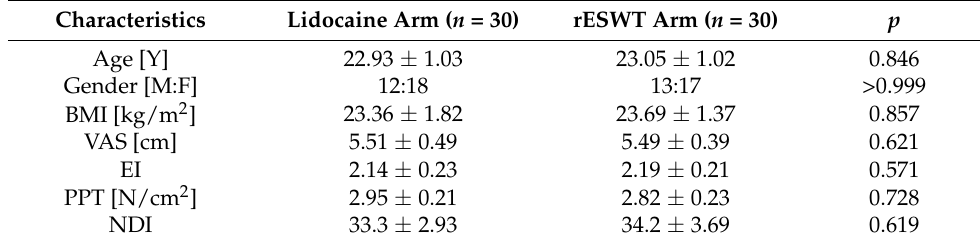
Table 1. Characteristics of the patients at baseline (mean ± standard